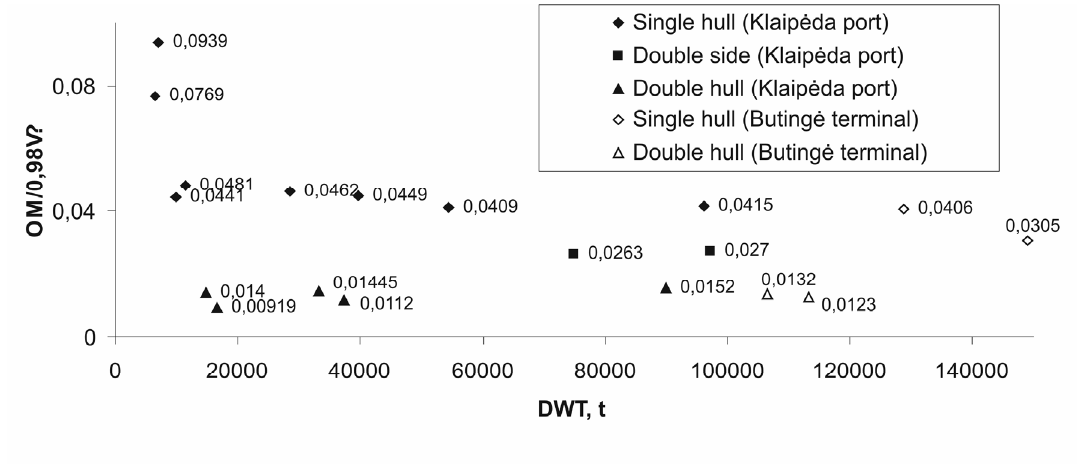
Fig 5. Estimated oil outflow parameters for some tankers, which entered Lithuanian ports in